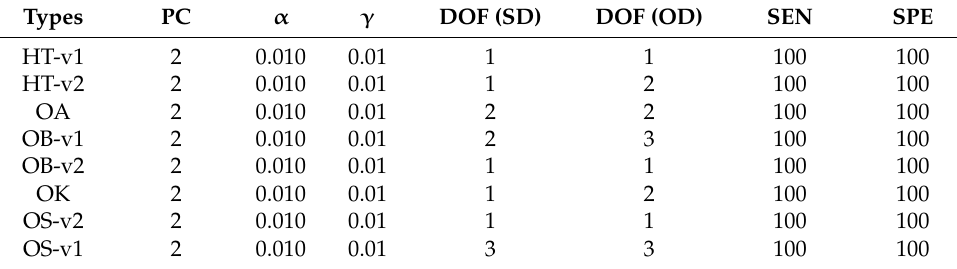
Table 2. Summarisation of the performance of the DD-SIMCA models for Ocimum variety